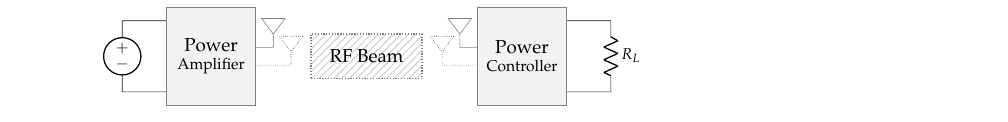
Figure 17. Schematic of an RFPT system. Antenna arrays (in dashed line) at the transmitter and/or receiver can be employed to increase the power